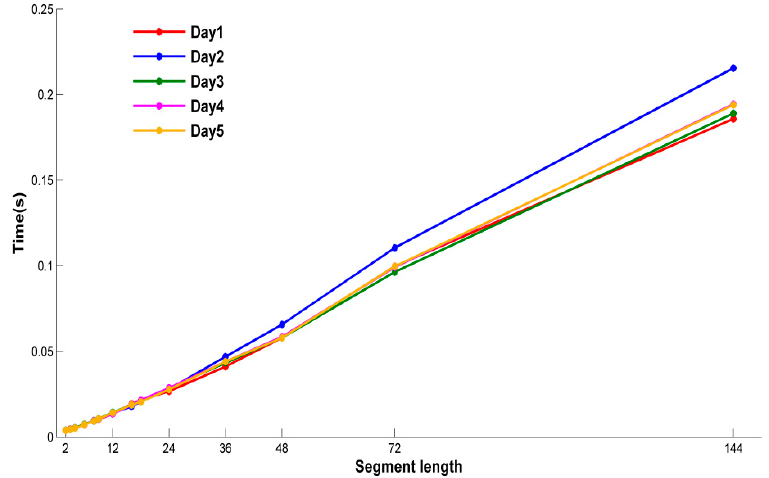
Figure 5. Time comparison of DTWS-ISD at different segment length in five days.